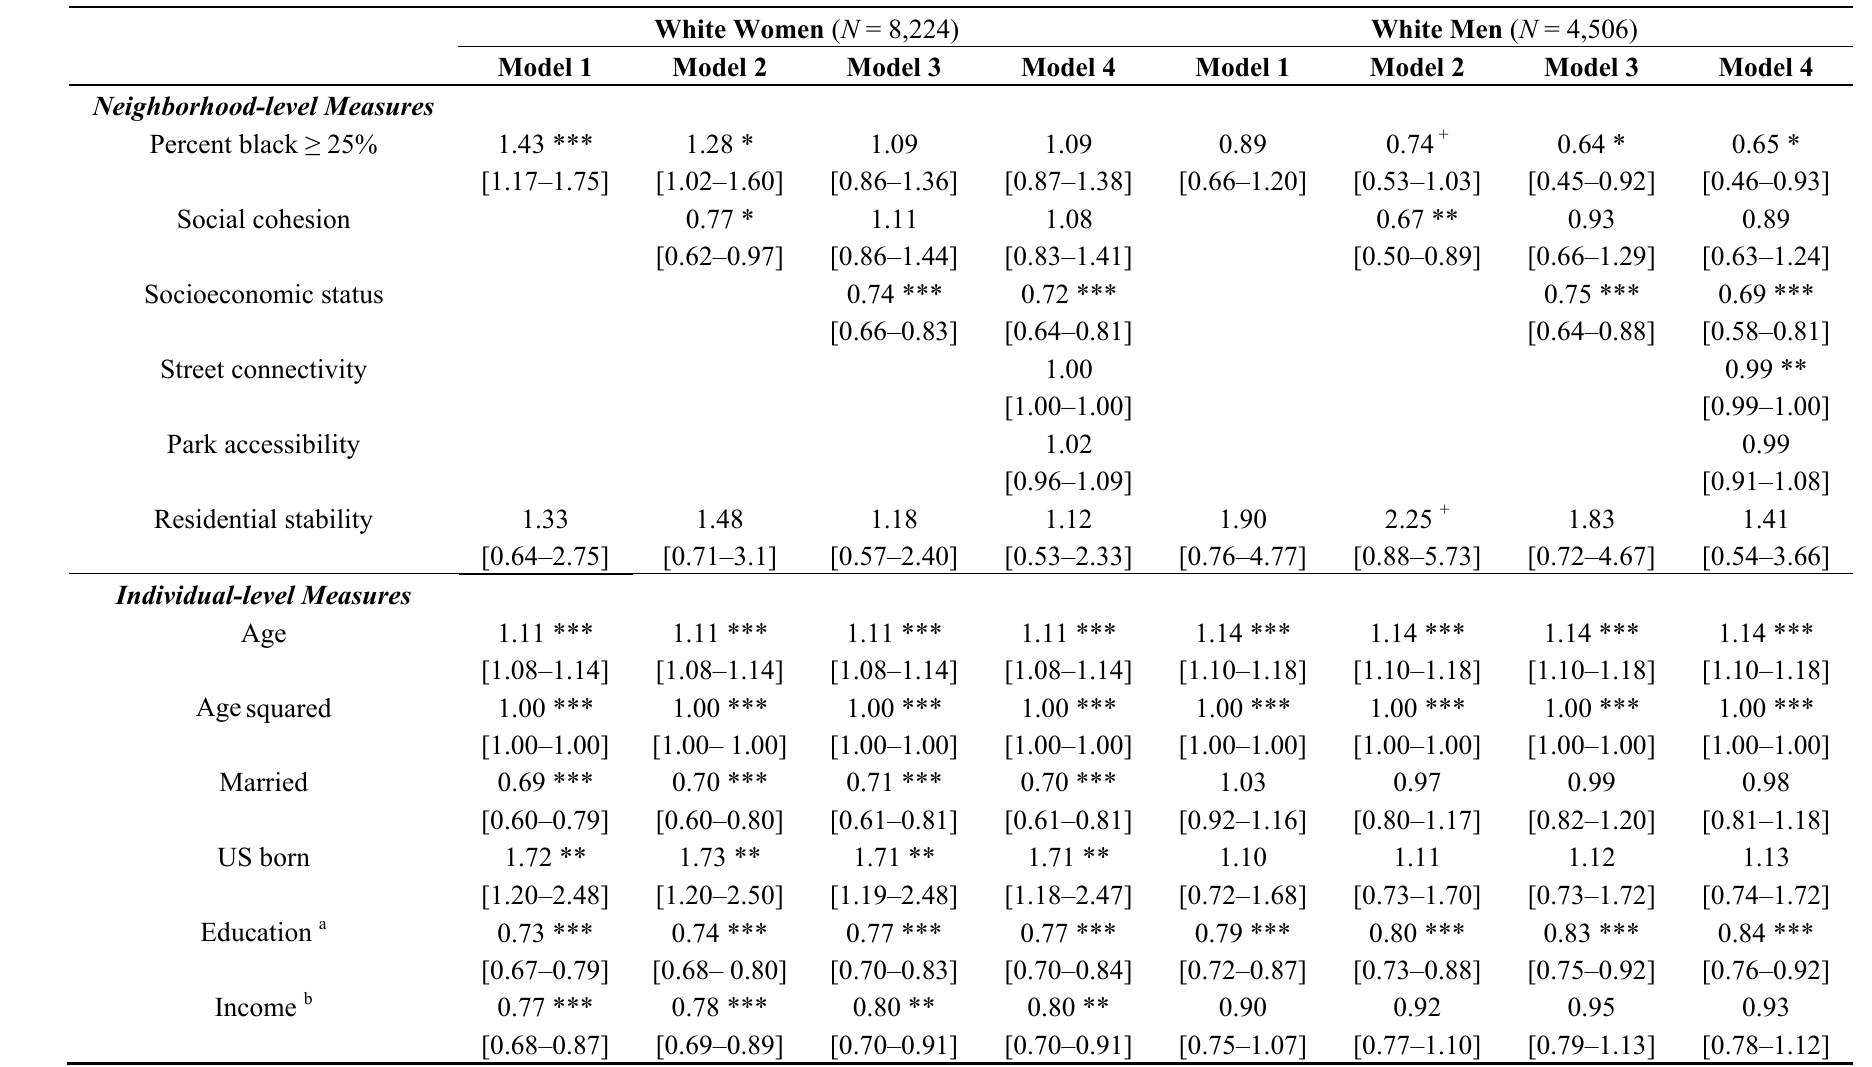
Table 3. Multilevel logistic regression odds ratio predicting obesity for white women and